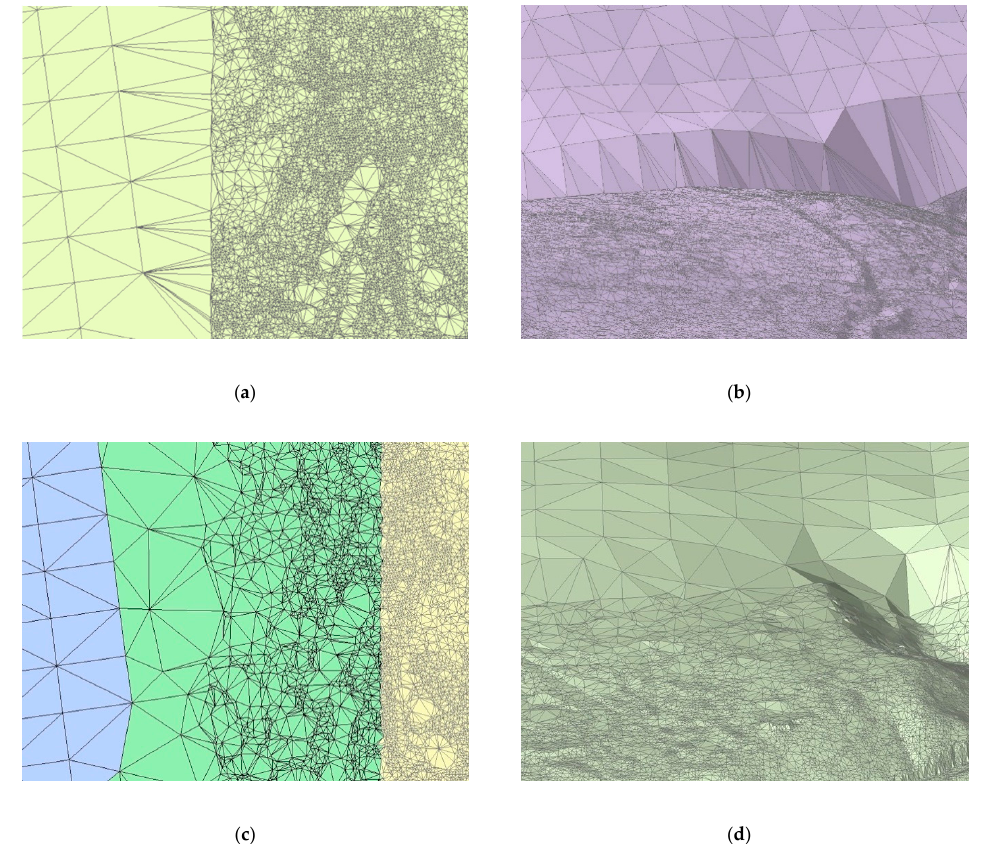
Figure 5. ( a ) The depiction of the triangulation of two datasets with highly different resolution resulting in a sharp divide and unnatural turn. ( b ) A 3D view on the boundary line and triangles with too small interior angles. ( c ) An illustration of the different DTMs geometries in the transition zone—low detail, high detail, and the transition zone illustrated with different colors. ( d ) The figure on the bottom right depicts a 3D view on the resulting geometry of the terrain. The resulting triangulation consists of triangles with far greater interior angles (more equilateral), which follows the objective of the Delaunay triangulation and therefore adheres more closely to the actual terrain course.